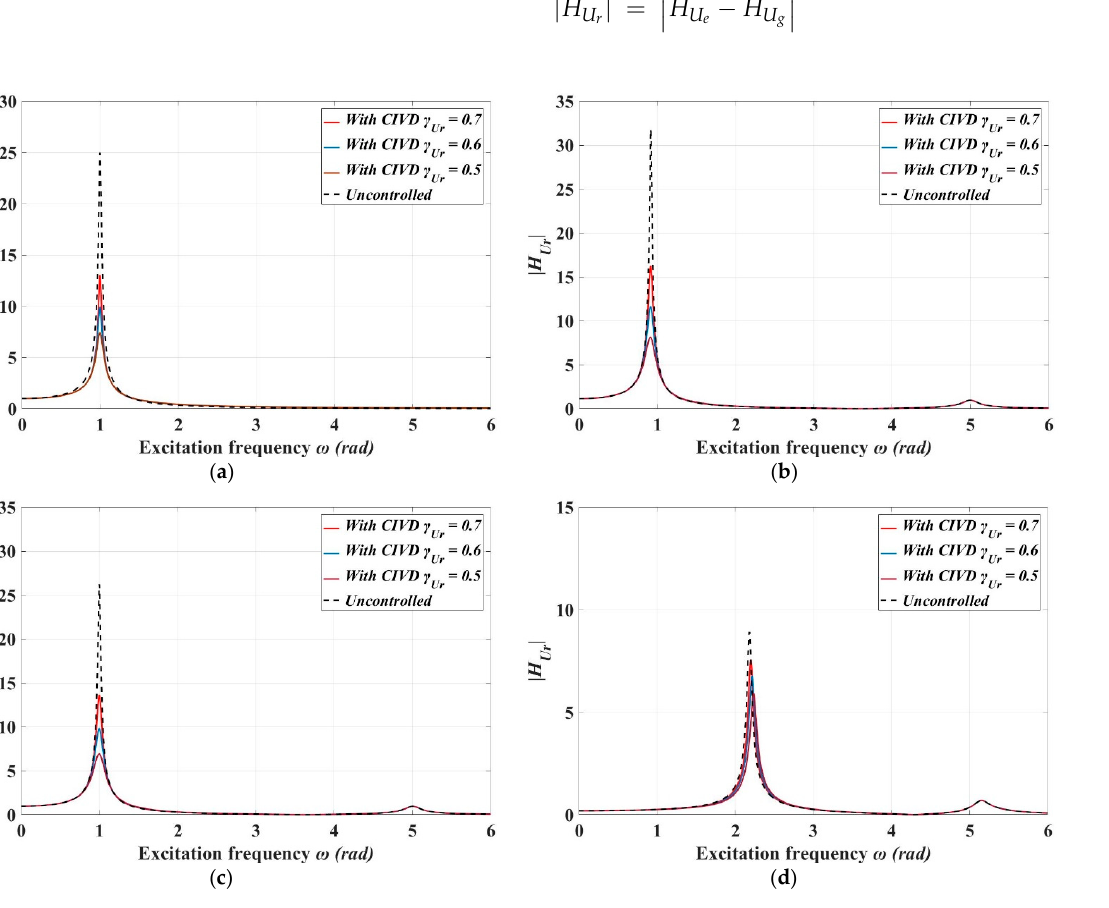
Table 2. Optimal parameters of CIVD.